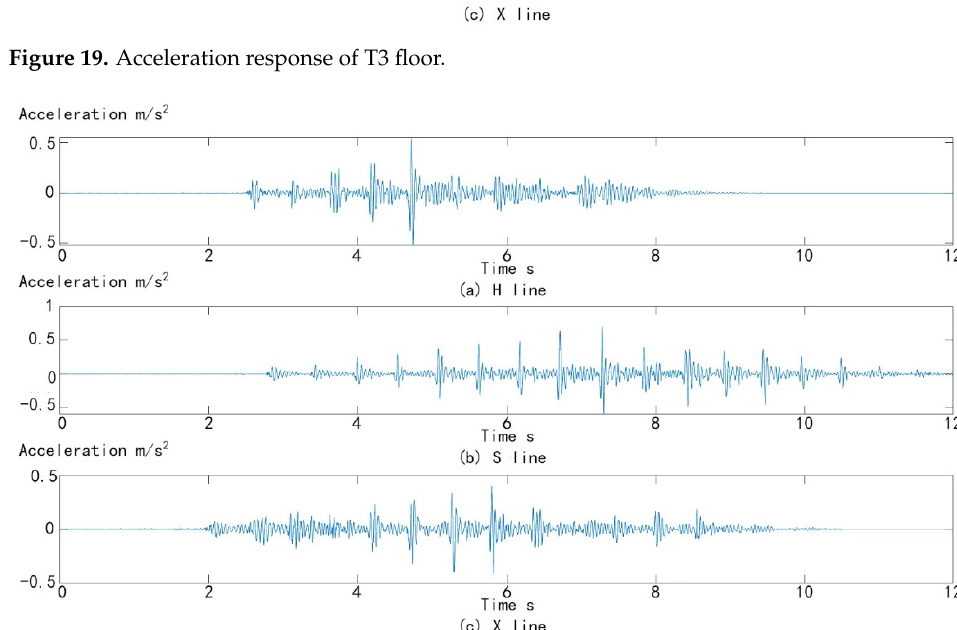
Figure 20. Acceleration response of T4 floor.